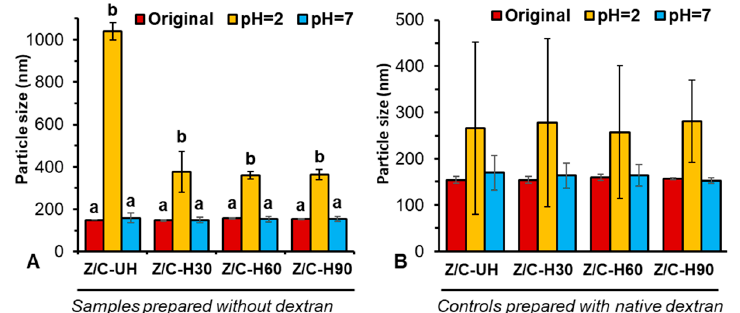
Figure 1. Characterization of biopolymer complex nanoparticles prepared without dextran ( A ) and with native dextran ( B ). Abbreviations: Z/C-UH, zein/NaCas nanoparticles without heating; Z/C-H30, -H60 and -H90: zein/NaCas nanoparticles with heating under 80 °C for 30, 60, and 90 min, respectively. Under each heating treatment, sample with different letters were significantly different at the level of p < 0.05.